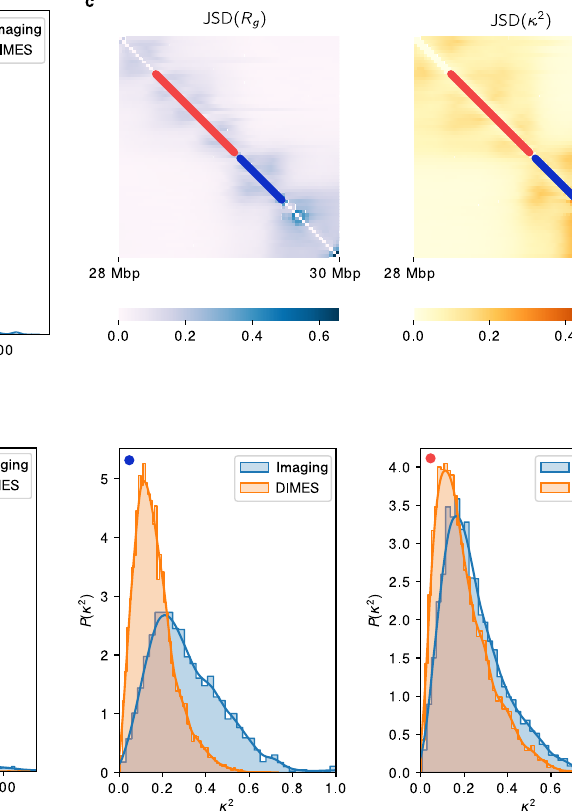
clusters of the conformations. The conformations naturally partition into two clusters (cluster #1 and cluster # 2 marked by blue and orange, respectively). A representative conformation from each cluster and the mean distance map com- puted from the conformations belonging to each cluster are also displayed.